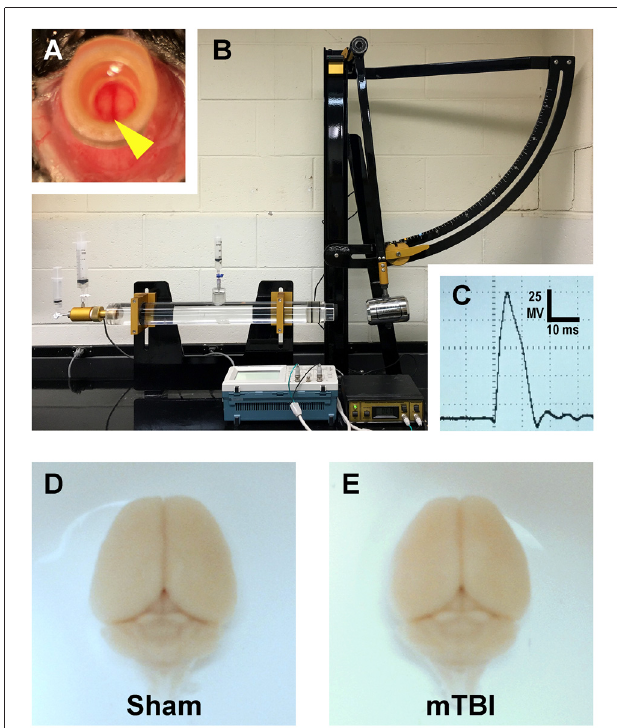
FIGURE 1 | Mouse model of mild traumatic brain injury (mTBI) via midline central fluid percussion injury (cFPI). (A) Dorsal view showing craniectomy site with the dura intact. The superior sagittal sinus (yellow arrowhead) can be seen through the saline-filled hub. (B) Fluid percussion injury device with the pendulum in the cocked position. Severity of injury is determined by arc height. After releasing the trigger the pendulum strikes a piston in a cylinder reservoir generating a fluid pressure wave. The mouse cranium is attached to the cylinder at the opposite end via the installed hub, forming a closed mechanical system. (C) A representative fluid pressure wave that is transmitted directly onto the intact dura. (D,E) Representative images of dissected brains perfused 2 days after cFPI-induced mTBI. Sham (D) and mTBI (E) brains show no evidence of surgically-induced damage. After cFPI, there is no evidence of mass lesions and/or contusion. There is no focal damage at the craniectomy site where the pressure wave entered the